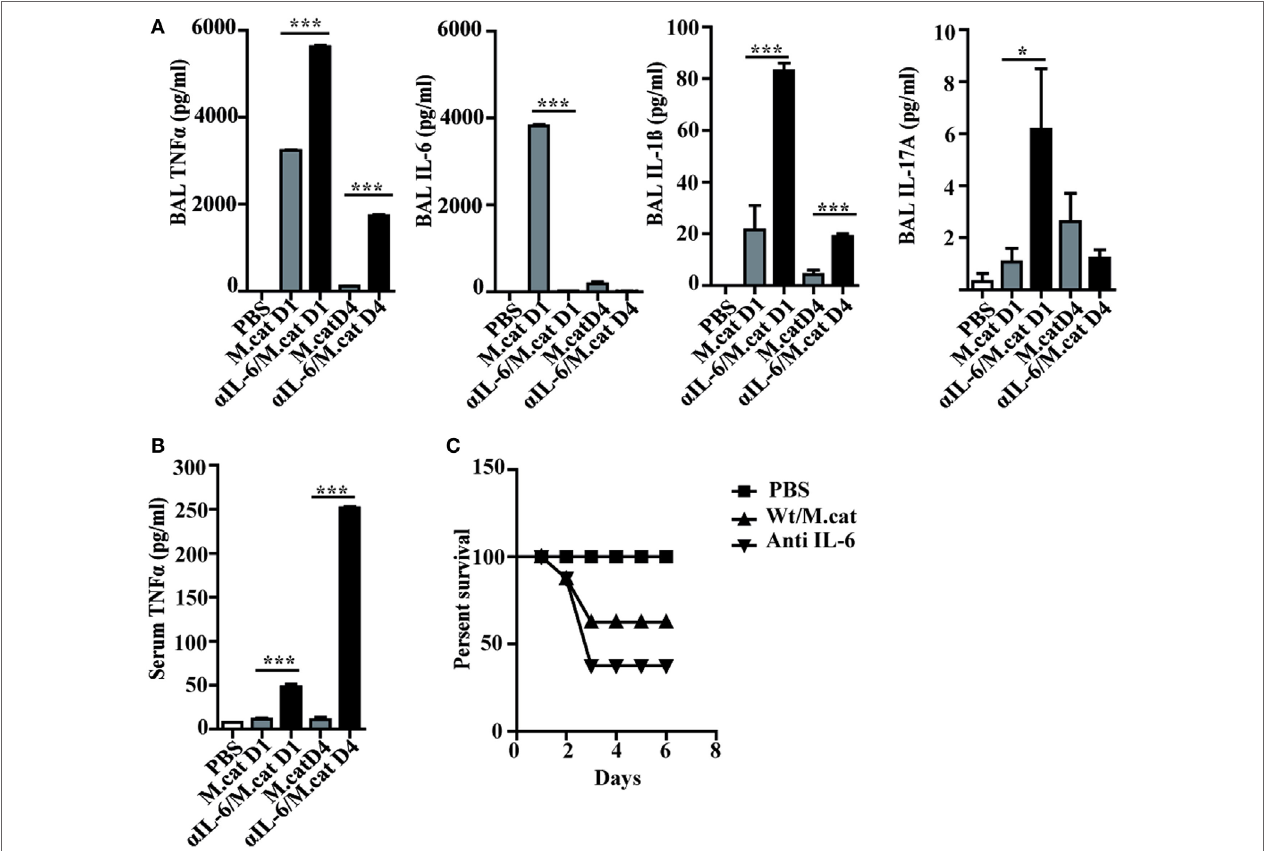
FigUre 4 | Neutralization of IL-6 enhances M. catarrhalis triggered inflammation. C57BL/6 animals received a single i.p. injection of 100 µg of anti-IL-6 or IgG1control mAbs and 4 h later were infected (i.n.) with M. catarrhalis (2 × 10 8 CFU) (a) Amounts of TNF- α , IL-6, IL-1 β , and IL-17 in BALF. (B) Amount of TNF- α in serum. (c) Survival of PBS-treated control mice (PBS), control-IgG1-treated animals infected with M.catarrahlis (Wt/M.cat) and anti-IL-6-mAb-treated animals infected with M. catarrhalis (anti IL-6). Data were from two independent experiments, n = 3 mice per group. *** P = 0.001, ** P = 0.01, and * P = 0.05 (one-way ANOVA). BALF, BAL fluid; PBS, phosphate-buffered saline; ANOVA, analysis of